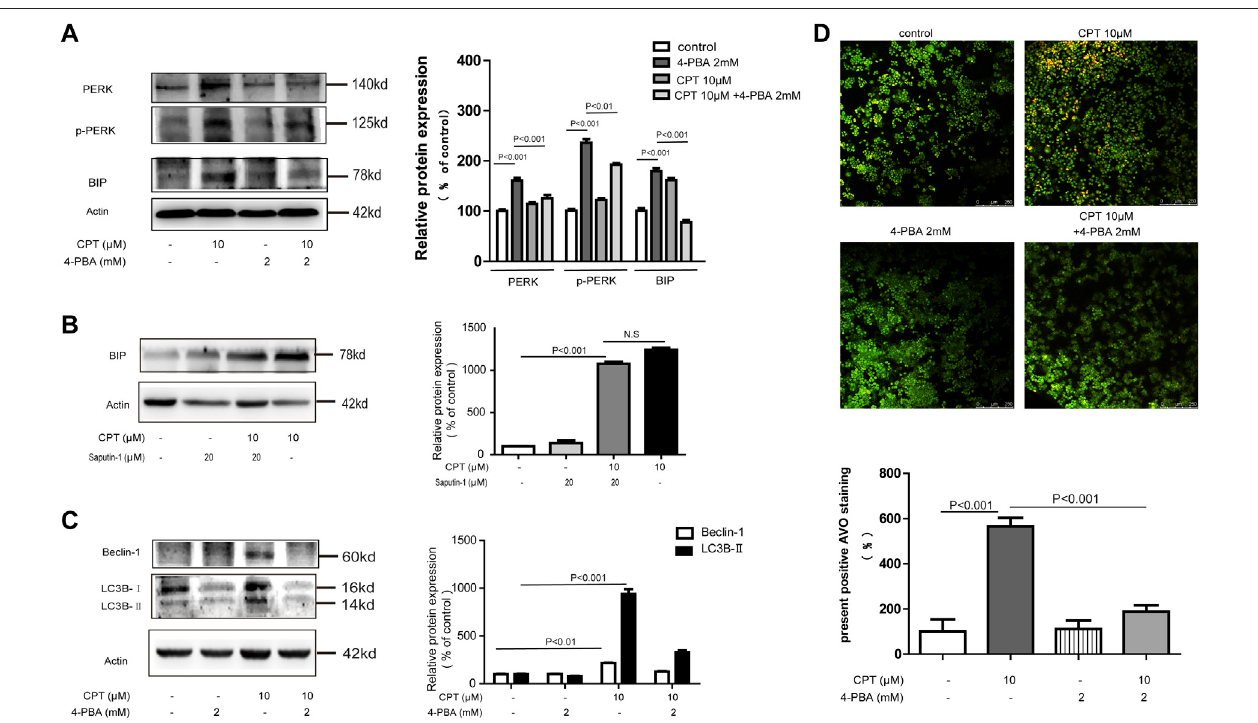
FIGURE 7 | CPT induced ER stress mediated autophagy in HCT116 cells. Expression levels of PERK and P-PERK in HCT116 cells treated with or without 4-PBA (2 mM) in the presence or absence of CPT (10 μ M) (A) . HCT116 cells treated with or without Spautin-1 (20 μ M) for 48 h were treated with or without CPT (10 μ M). The expression of BIP in the lysate was determined by western blot and quanti fi ed by Image J (B) . To test for Beclin-1 and LC3 expression in 10 μ M CPT processed or untreatedHCT116 cells, with orwithout4-PBA (2 mM) (C) . Under fl uorescence microscope (200 × ),thenumber ofautophagosomes inHCT116 cellswasstained by AO staining and quanti fi ed by ImageJ software (D) . CPT, cryptotanshinone; ER stress, endoplasmic reticulum stress; AO, acridine orang.